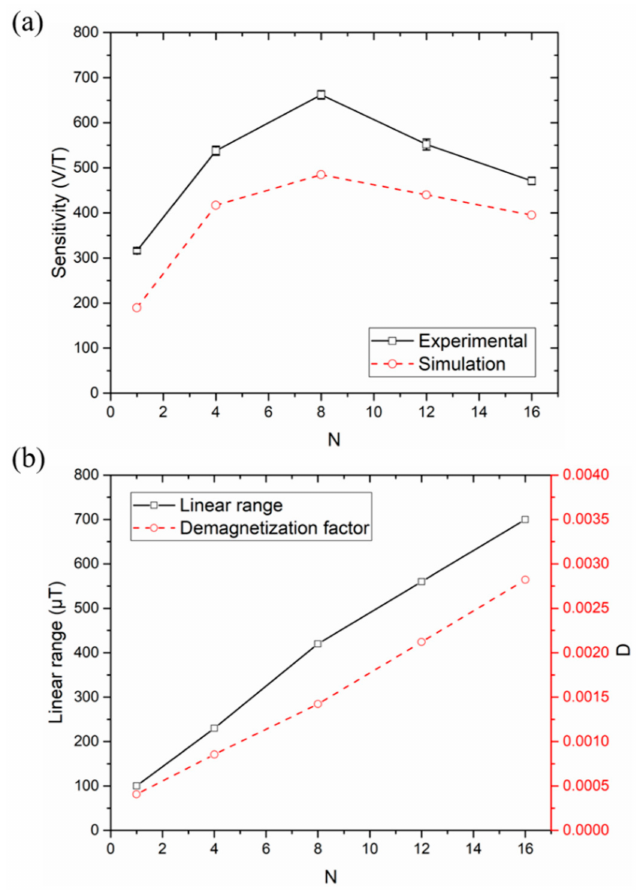
Figure 4. ( a ) The sensitivity of the experiment and simulation as a function of the number of strips. ( b ) The linear range as a function of the number of strips, and a comparison with the demagnetization factor D